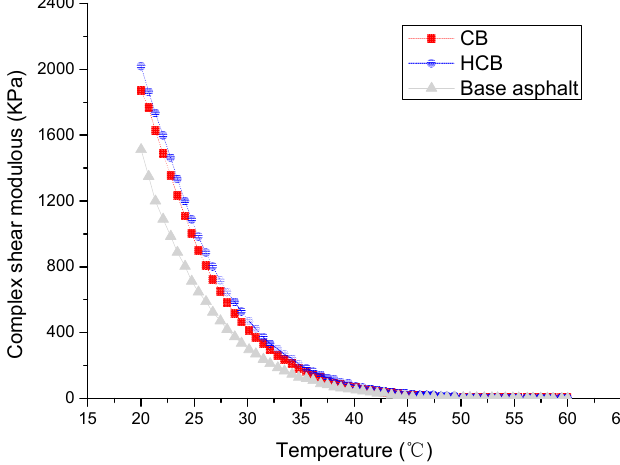
Figure 6. Effect of CB and HCB on complex shear modulus of asphalt. Figure 6. E ff ect of CB and HCB on complex shear modulus of